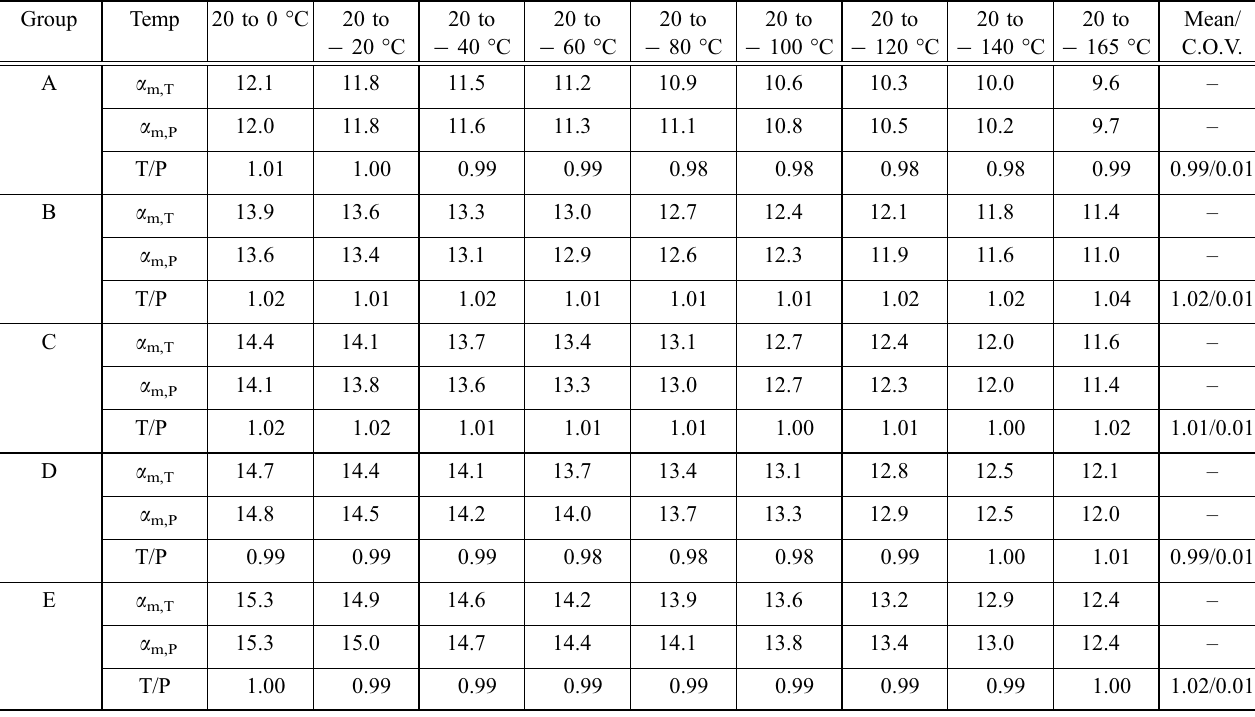
Table 3 Average linear thermal expansion coefficients for steel strands under different low temperature and prestressing stress. Group Temp